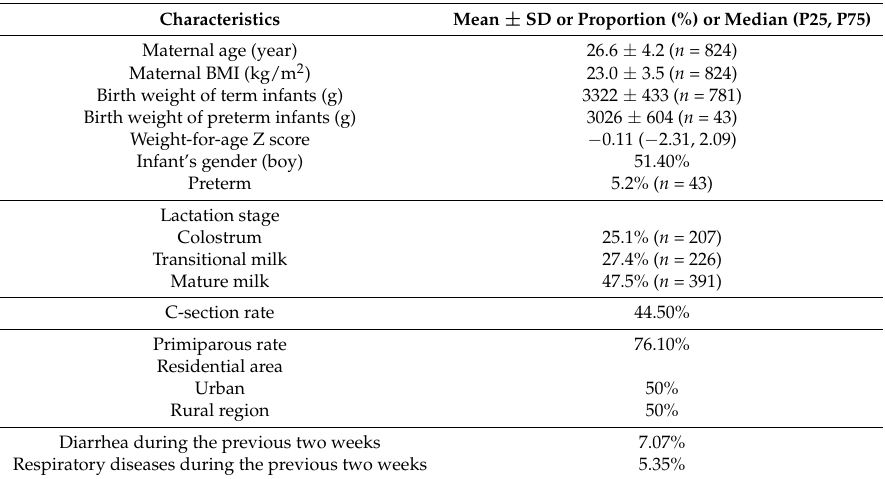
Table 1. Characteristics of study subjects.